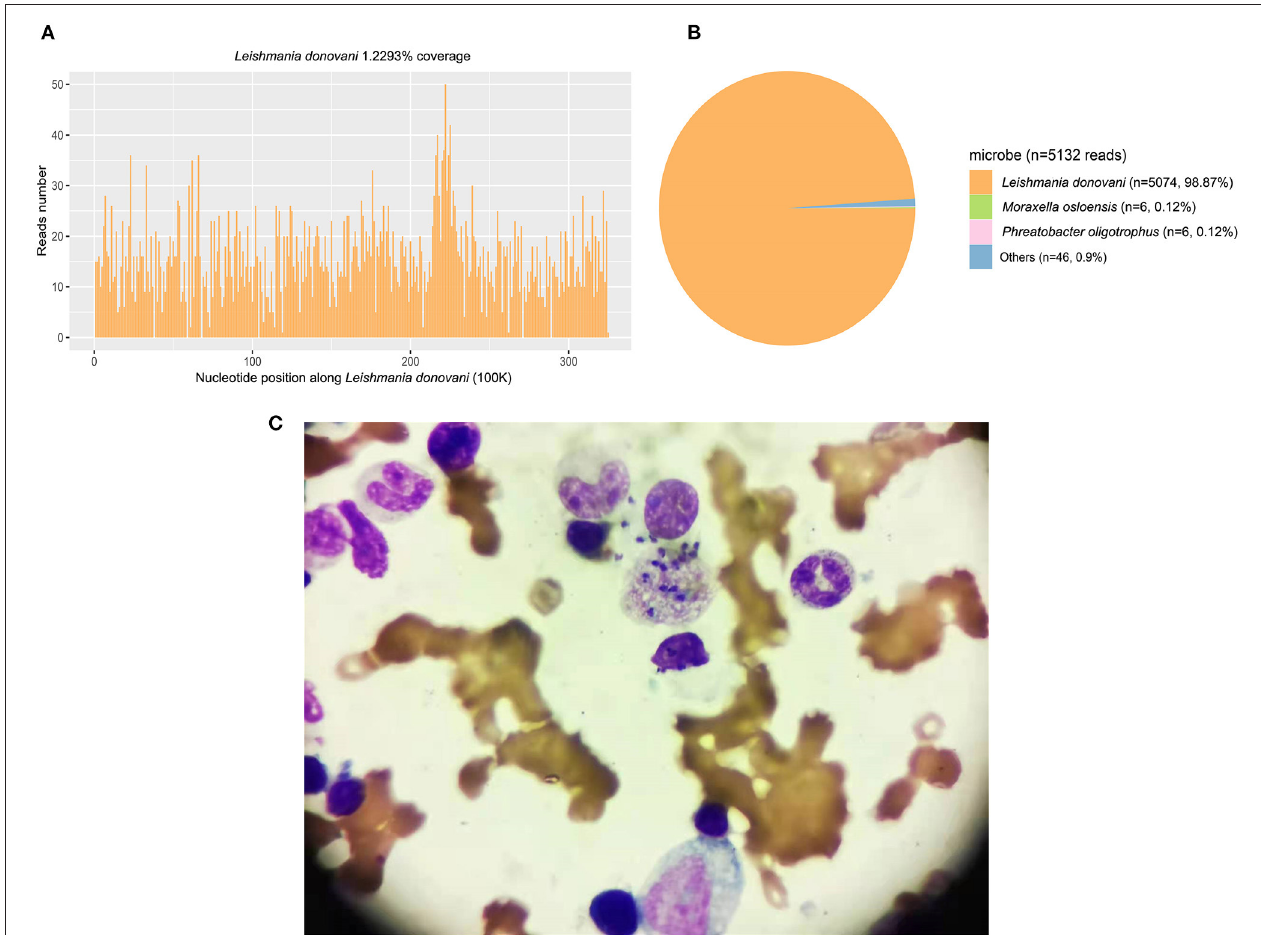
FIGURE 1 | The mNGS and bone marrow result detected in Case 1. (A) The genome coverage of the detected reads of Leishmania shedunii. (B) The abundance of detected microbe and their reads numbers. A total of 5074 specific reads (98.87%) of Leishmania were detected in the blood sample. (C) The examination of a bone marrow aspirate revealed